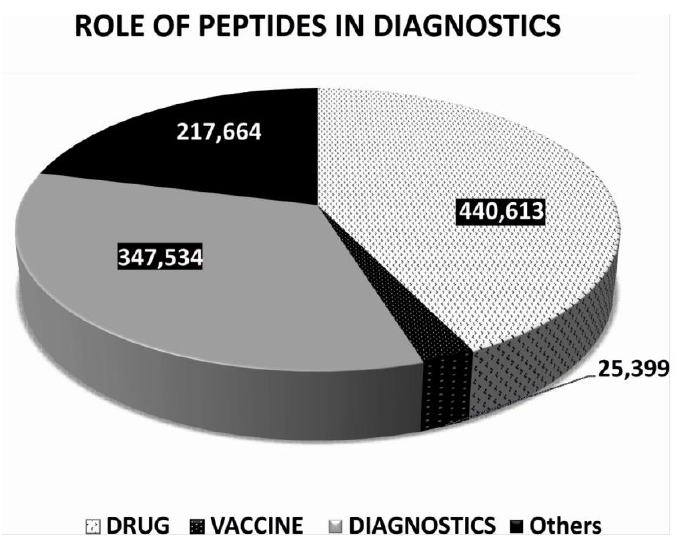
Figure 2. Based on scientific research published on PUBMED in the last decade (1 January 2011 to 31 December 2020).